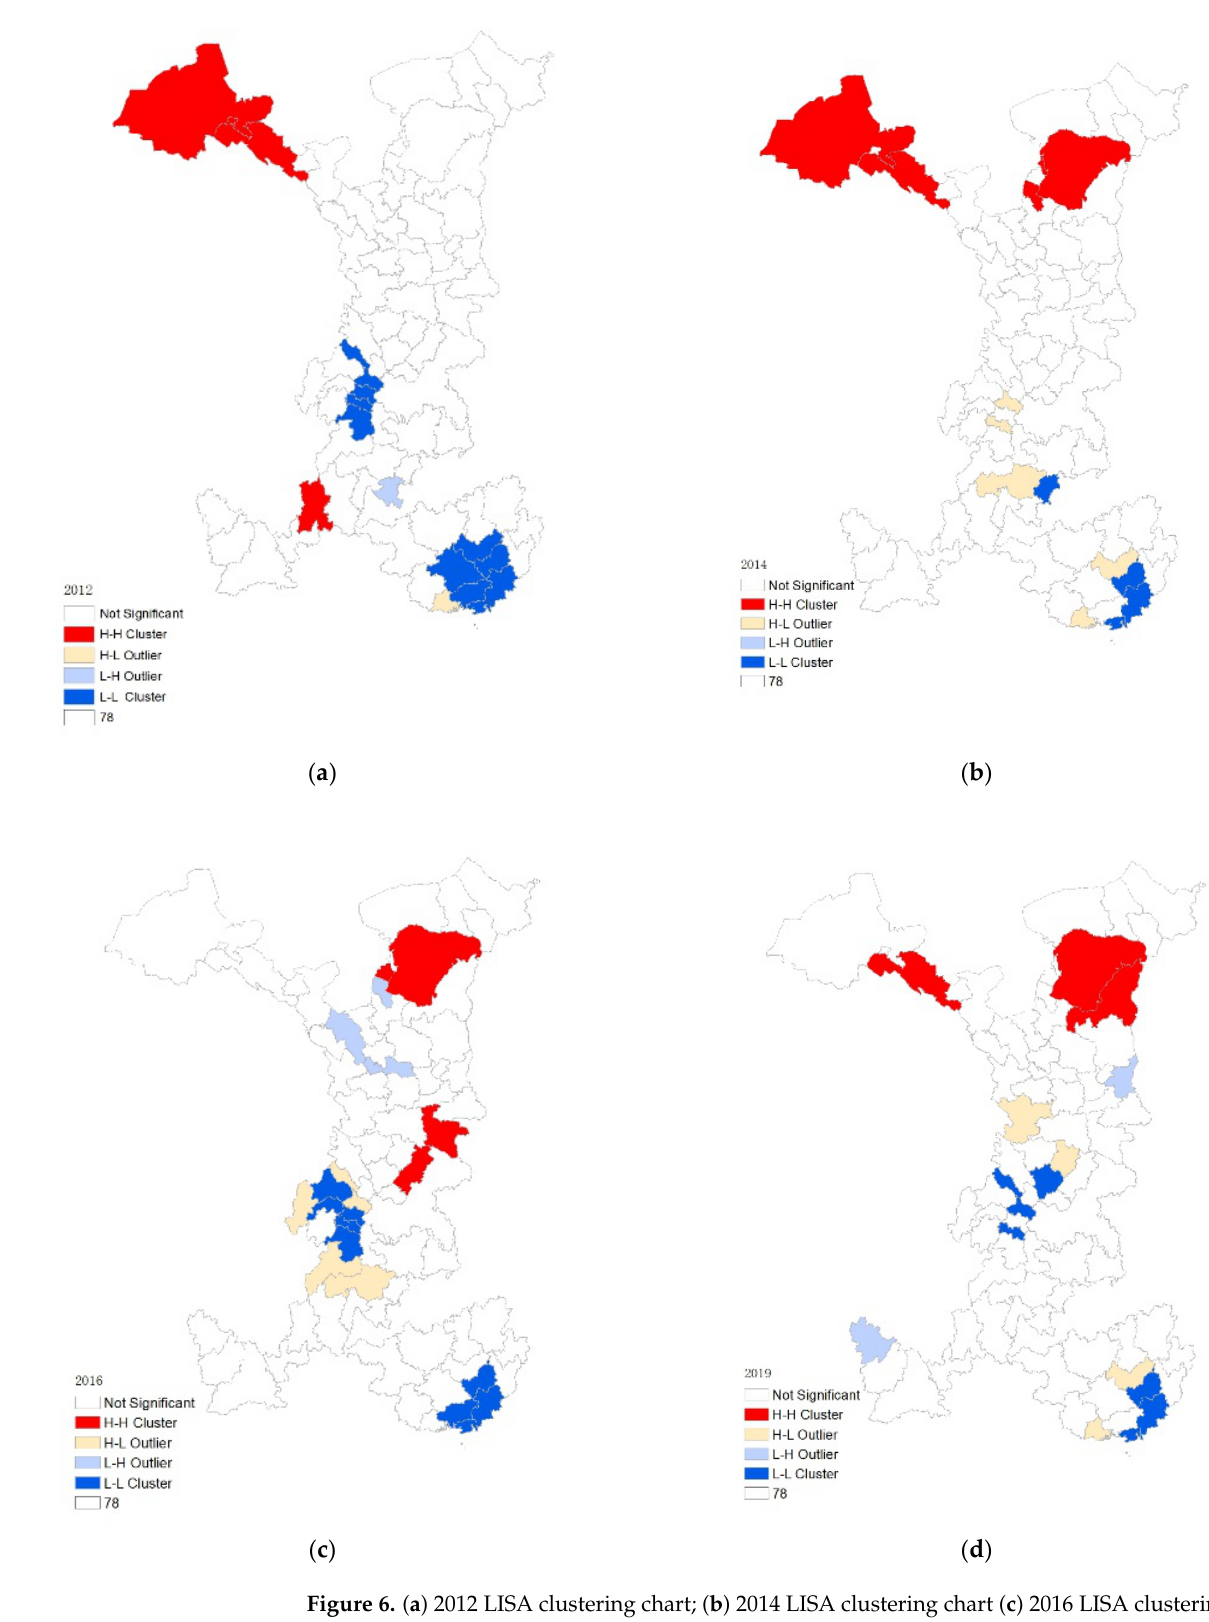
Figure 6. ( a ) 2012 LISA clustering chart; ( b ) 2014 LISA clustering chart ( c ) 2016 LISA clustering chart; ( d ) 2019 LISA clustering chart.